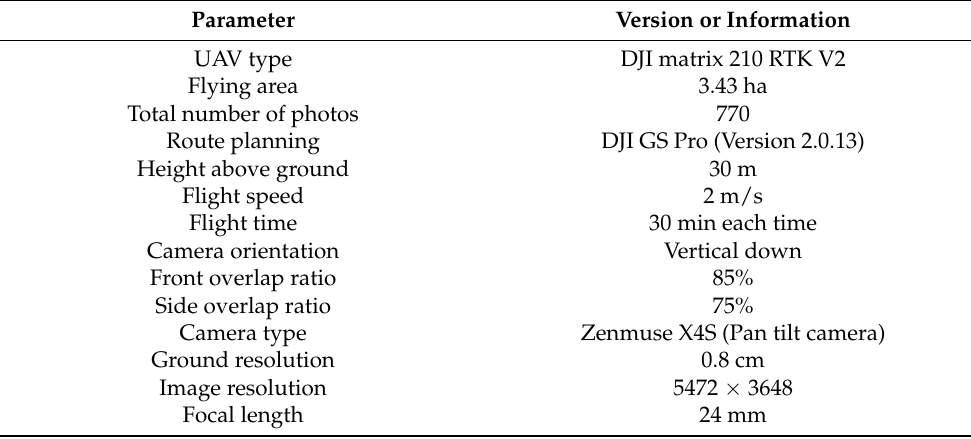
Table 3. Details of the unmanned aerial vehicle (UAV) platform and its settings for image acquisition of maize